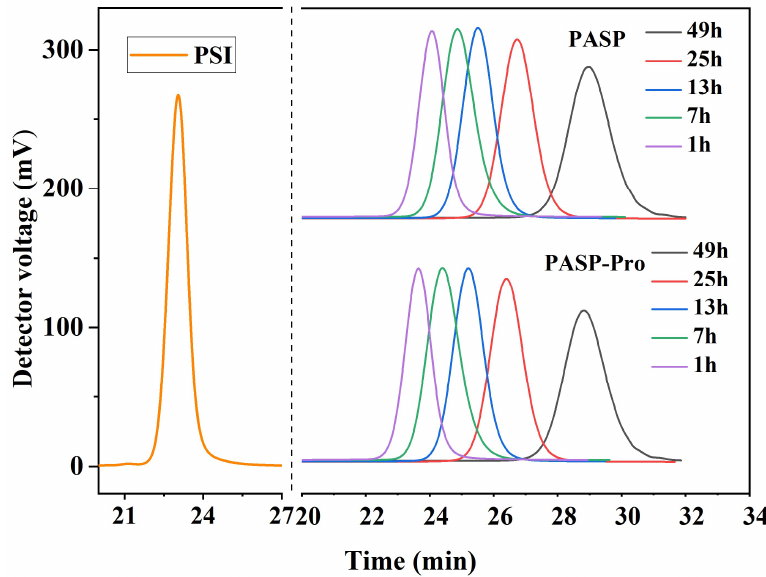
Figure 4. GPC of PSI, PASP, and PASP-Pro. Table 1. Data resulting from GPC analysis for PSI, PASP, and PASP-Pro.